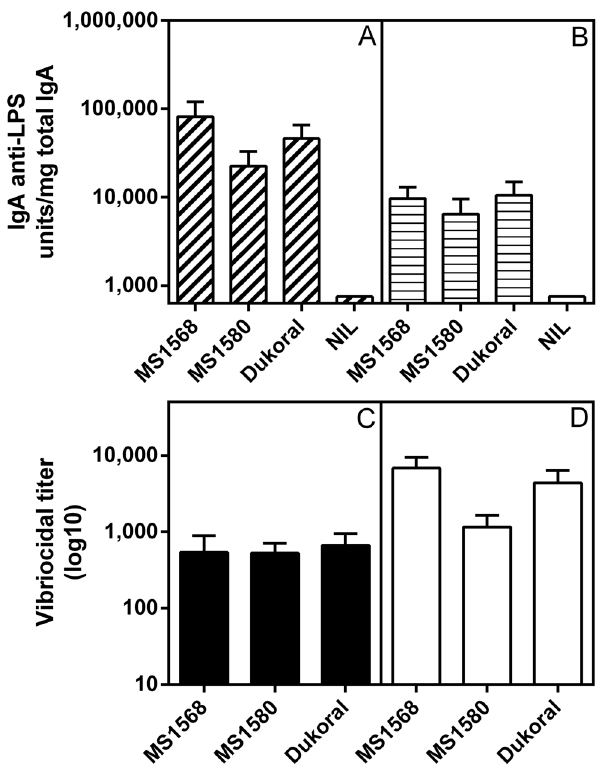
Figure 4. Intestinal–mucosal IgA anti–LPS and serum vibrioci- dal antibody responses elicited by two rounds of oral immunizations in Balb/c mice two weeks apart with formalin– killed MS1568 and MS1580 whole cell vaccines as compared to Dukoral vaccines; immunizations and collection of tissue specimens are fully described in Materials and Methods. (A) IgA anti–LPS antibody levels in fecal extracts (expressed as units per mg of total IgA measured by ELISA); and (B) the same in small intestinal tissue extracts. (C) Serum vibriocidal antibody responses against Inaba test organisms; and (D) the same against Ogawa test organisms. Bars represent the pooled results (geometric mean values 6 SEM) from two separate experiments in Balb/c mice, each with 8 animals per group. Analyses of data by ANOVA showed that post–immunization antibody levels did not differ significantly between any of the immunization groups.